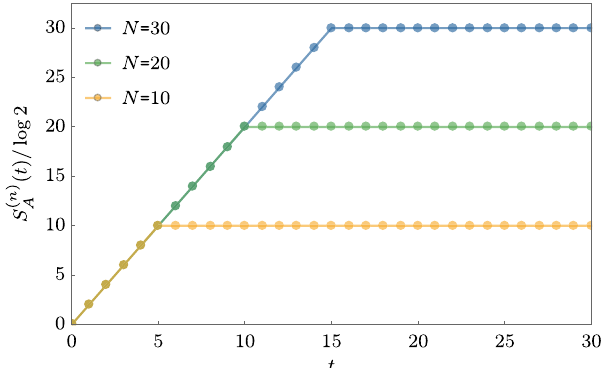
FIG. 2. Plot of the exact result of all R´enyi entropies given by Eq. (23) for the θ ¼ π = 2 case. The expressions for θ ¼ 0 are delayed by one